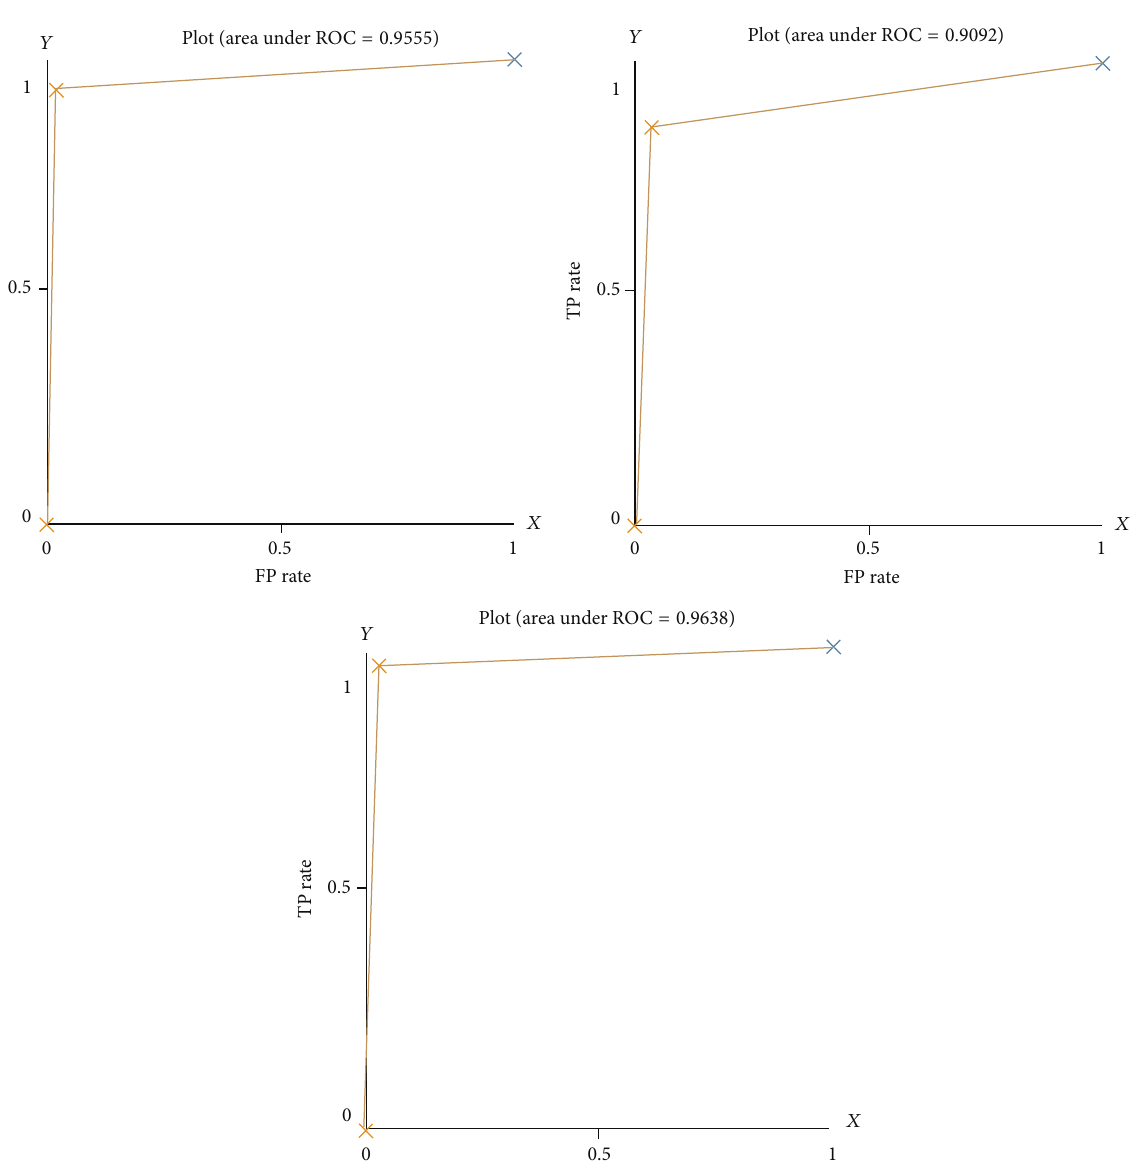
Figure 8: ROC curve of three classes (single, multiple, and multiple abnormal) on our testing data set for 10 MHI frames.